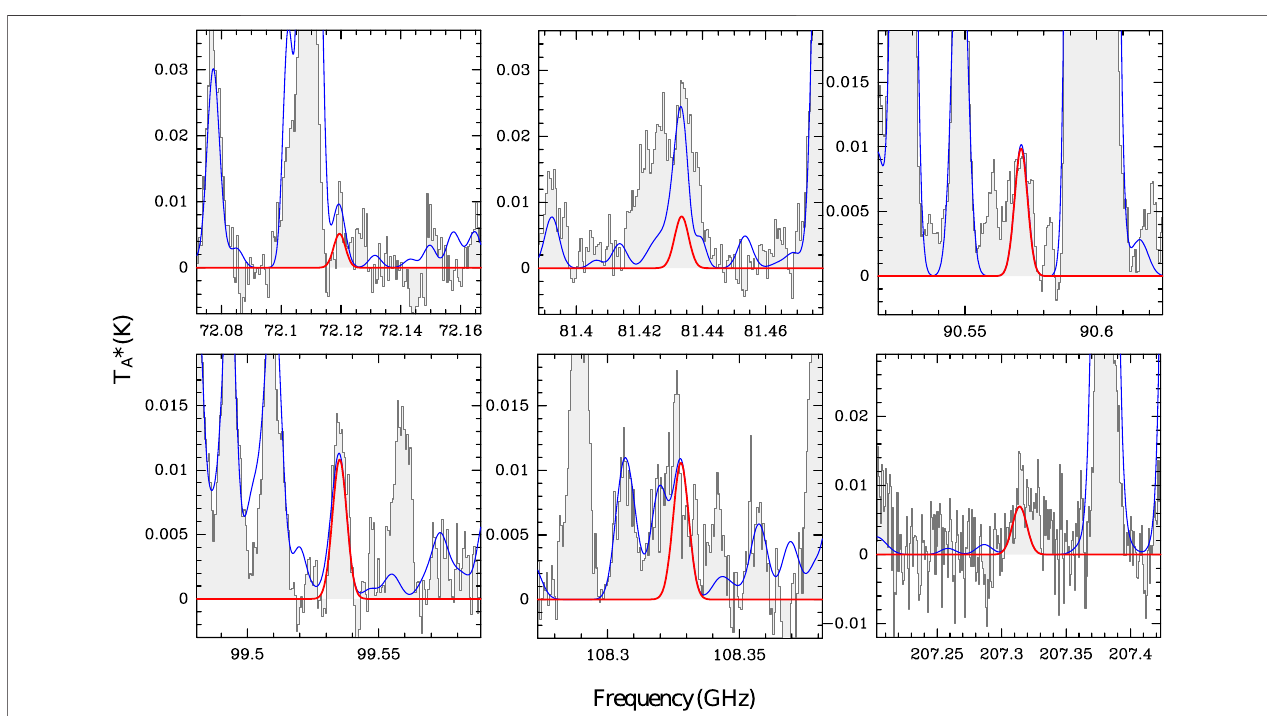
FIGURE 3 | Selected cyanoformaldehyde (HCOCN) transitions (see Table 2 ) detected towards the G+0.693 molecular cloud. The best LTE fi t derived with MADCUBAfortheHCOCNemissionisshownwitharedcurve,whilethebluecurveshowsthetotalemissionconsideringallthespeciesidenti fi edtowardsthismolecular cloud. The y-axis shows the line intensity in antenna temperature scale ( T A * ) in Kelvin, and the x-axis shows the frequency in GHz.